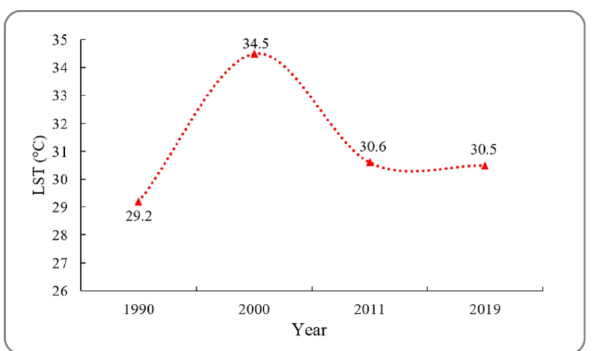
Figure 7. Changes in the mean value of the Mashhad city LST for Mashhad in the period 1990–2019.